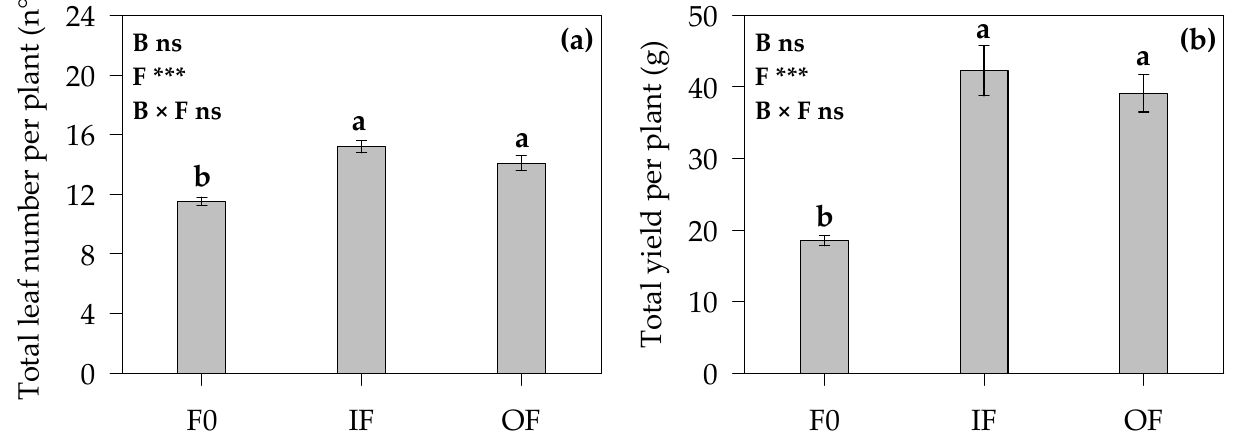
Figure 1. Main effect of fertilizer on total leaf number per plant ( a ) and total yield per plant ( b ) of Swiss chard. B, biochar; F, fertilizer. F0, no fertilizer; IF, inorganic fertilizer or ammonium nitrate; OF, organic fertilizer or vermicompost from cattle manure. Values are means ( n = 4) ± standard errors. Different letters above histograms indicate significant differences among treatments ( p ≤ 0.05; Table 6. Content of anions (P 2 O 43 − , SO 42 − , NO 3 − , mg kg − 1 fw), cations (Na + , Ca 2+ , Mg 2+ , mg kg − 1 fw) and total nitrogen (total N, % dw) in Swiss chard